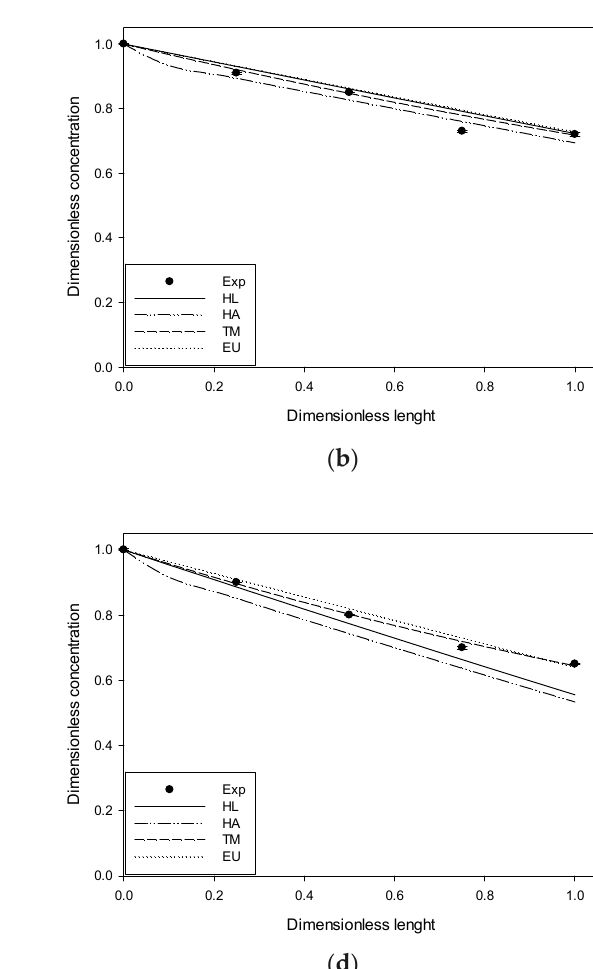
Figure 2. Nondimensional simulation results compared to experimental data with 4 ppm of input.